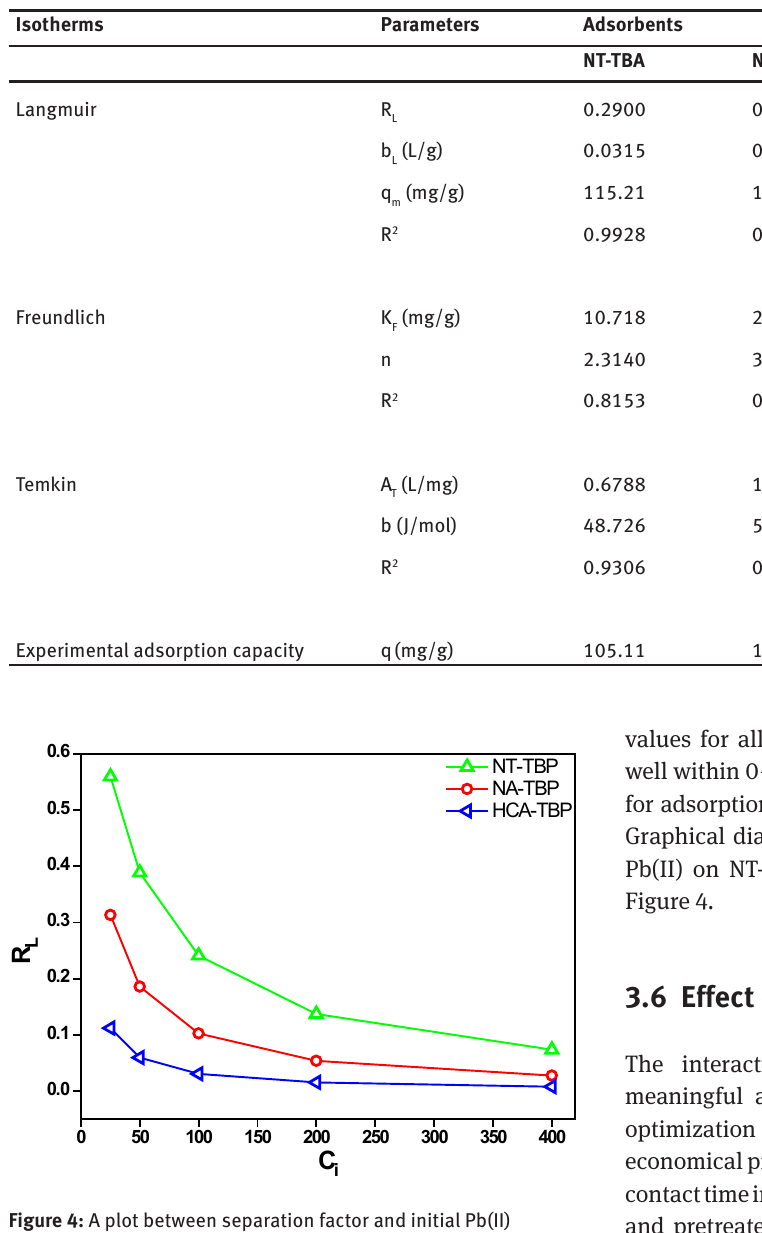
Figure 4: A plot between separation factor and initial Pb(II)